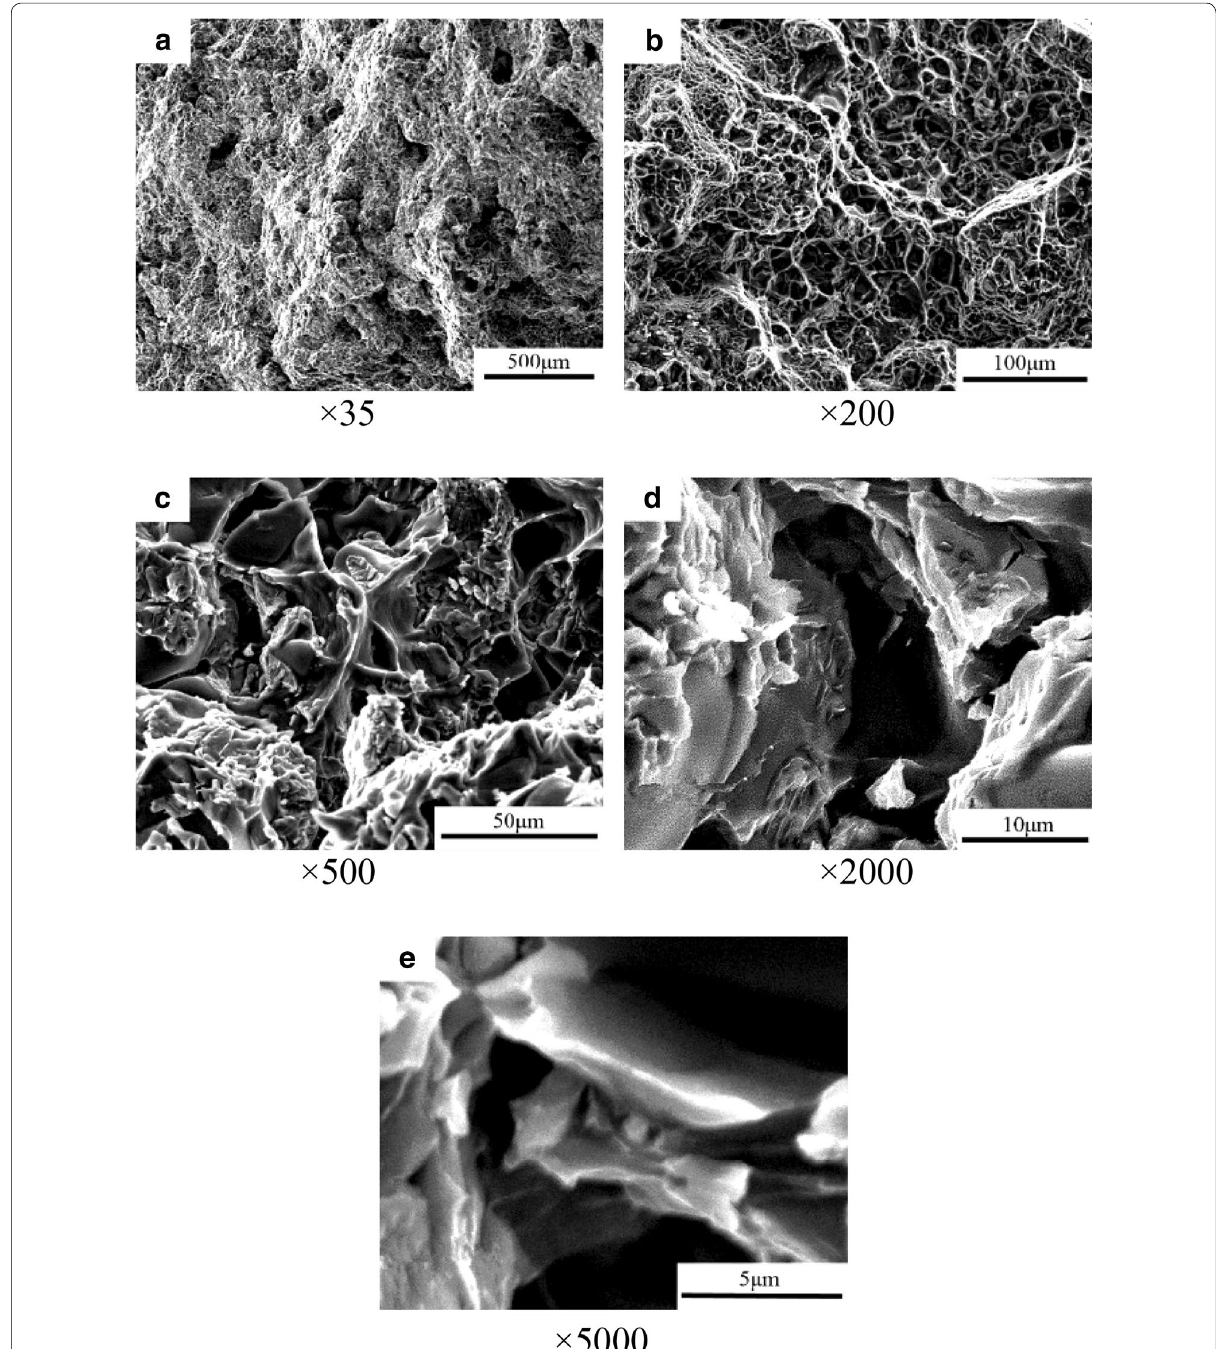
Figure 2 Fracture morphology of the as‑cast alloy under different